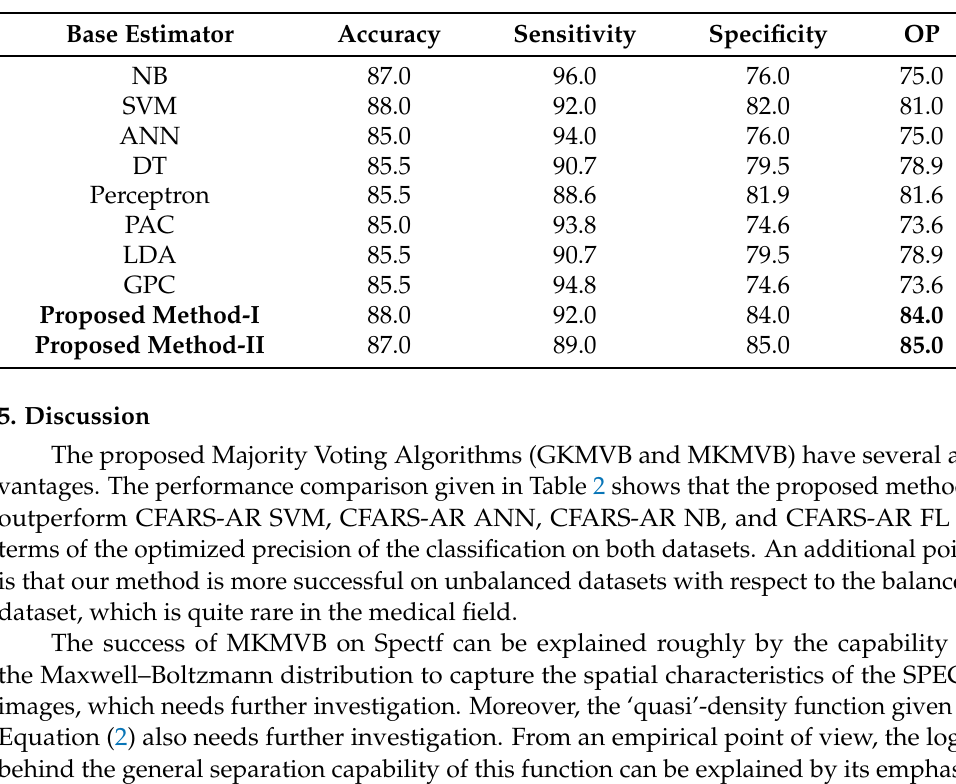
Table 5. Statlog Results with different base